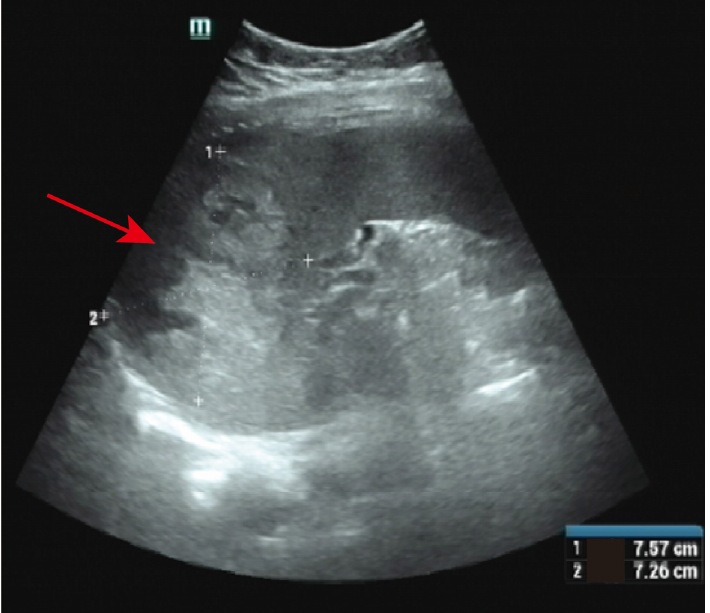
Figure 2. Ultrasound showed abnormal hyperechoic areas in the spleen (solid red arrow).